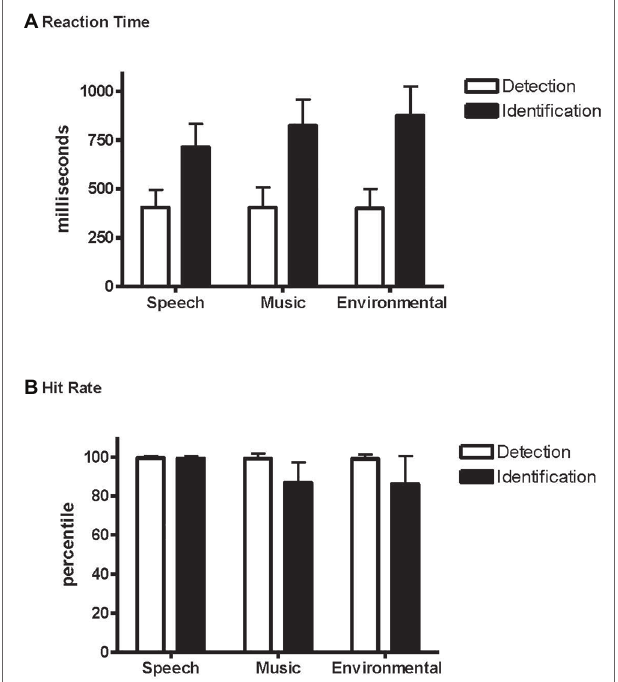
FIGURE 3 | Detection and Identification conditions. (A) Reaction time (RT): mean reaction time to speech, music, and environmental sounds, indicated separately with white bars for the Detection condition and with black bars for the Identification condition. Whiskers show the standard deviations. (B) Hit rate (HR): mean hit rate to speech, music, and environmental sounds, indicated separately with white bars for the Detection condition and black bars for the Identification condition. Whiskers show the standard